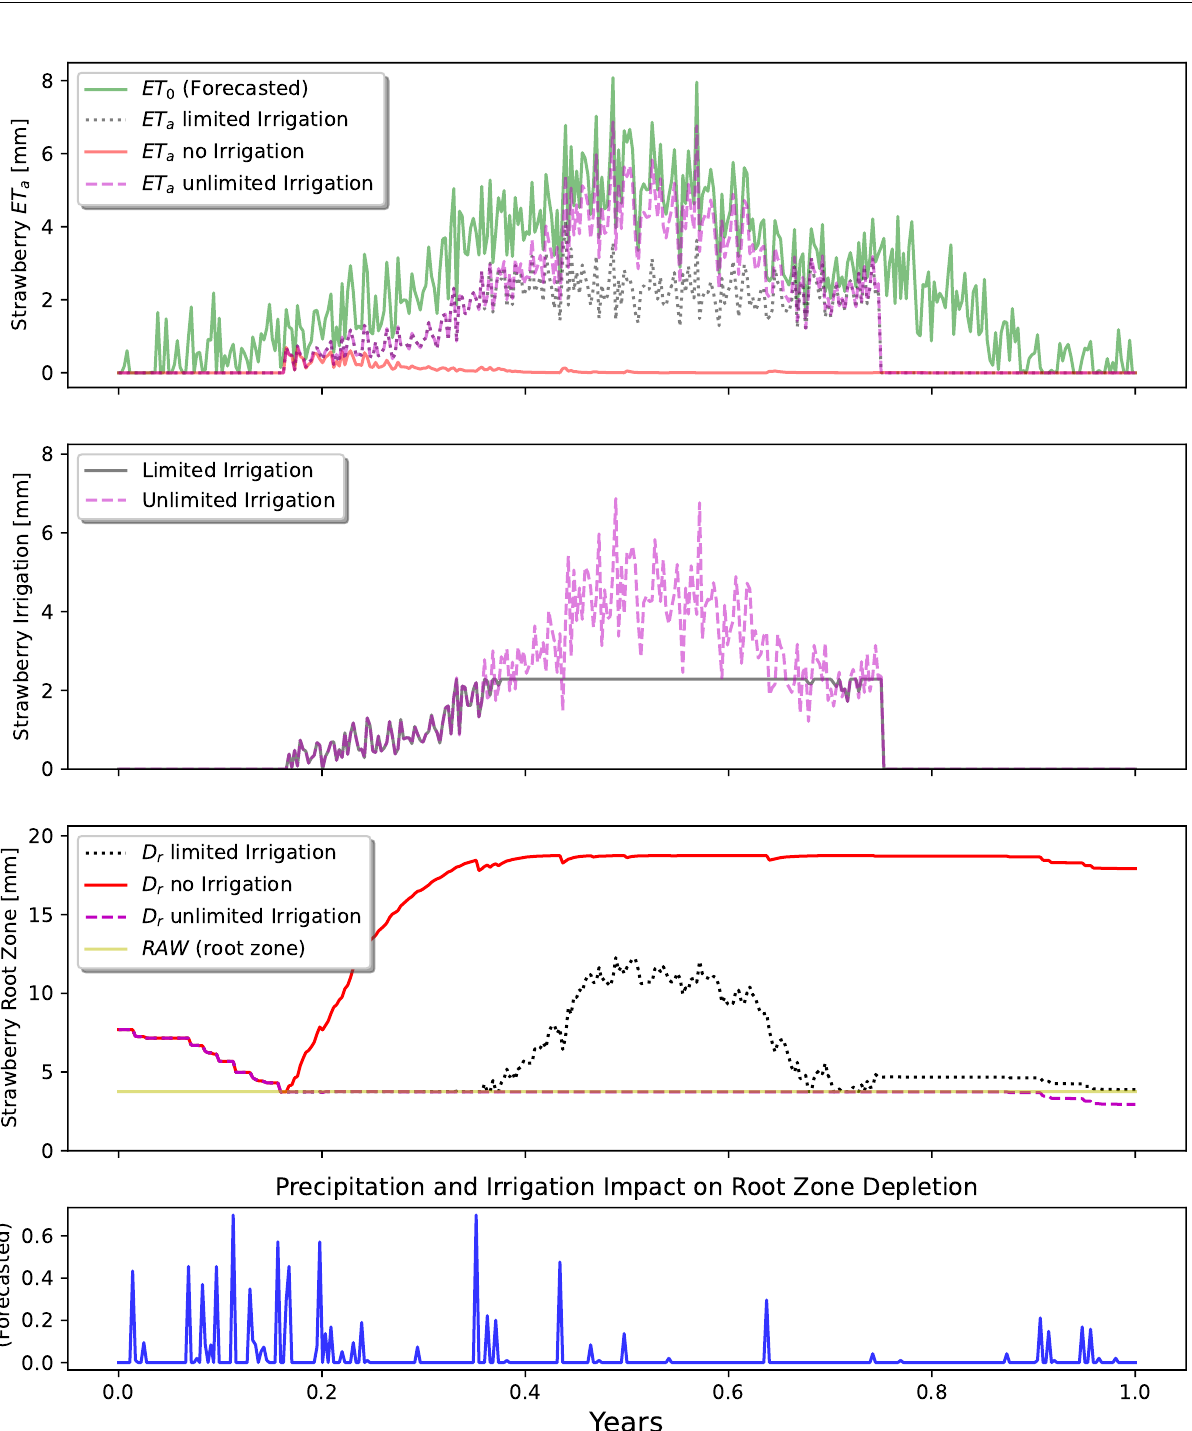
Figure 5. Depiction of root zone water use, irrigation, and ET for strawberries over a single growing season forecast. Root zone depletion is visible for dry periods when irrigation was limited, resulting in reduced crop